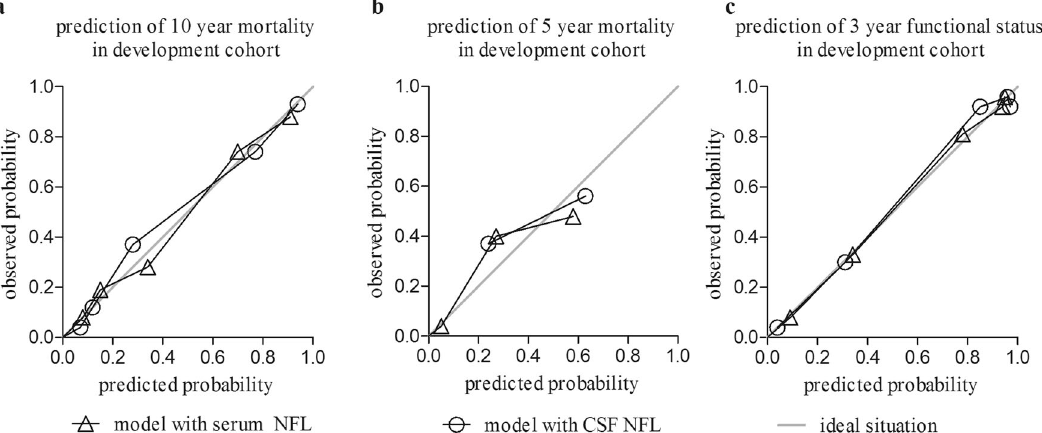
Fig. 2 Calibration plots of the prediction model per outcome measure in the discovery cohort. Calibration plots of prediction models in the discovery cohort for prediction of ( a ) 10-year mortality, ( b ) 5-year mortality, and ( c ) 3-year functional outcome. The gray reference line represents the ideal line. Observed probabilities are indicated by quintiles of predicted probability.